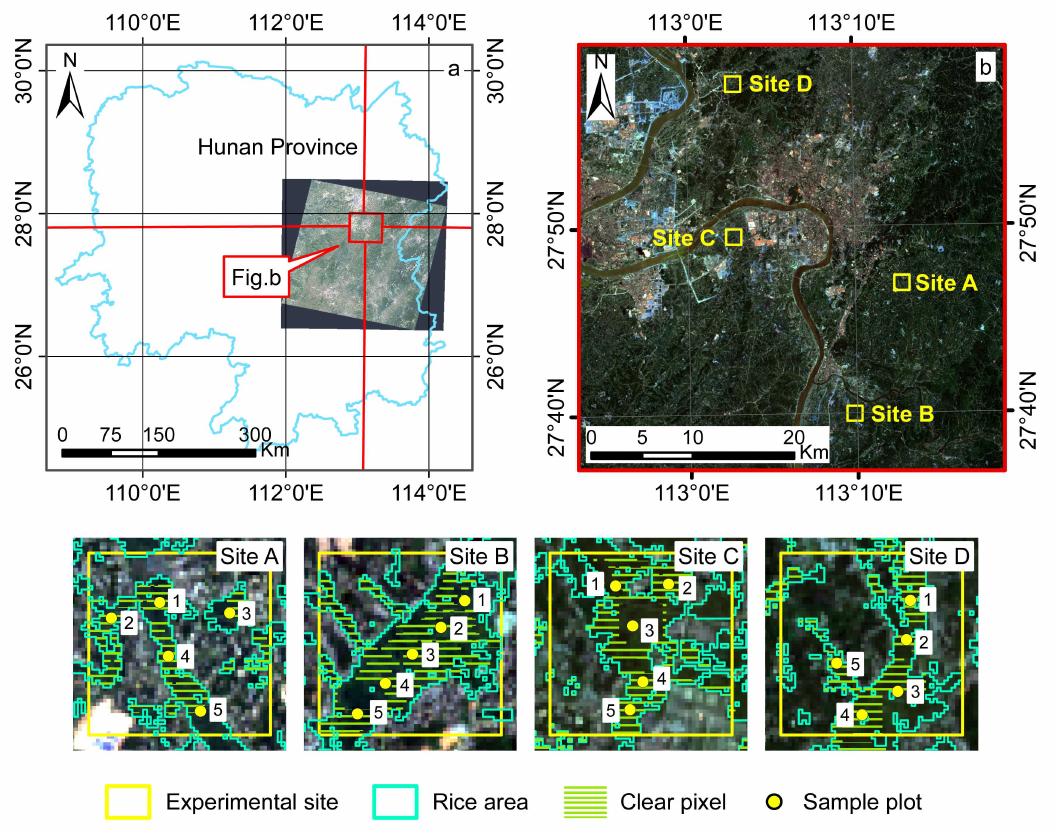
Figure 1. Location of the experimental sites in Zhuzhou, Hunan Province, China, and the spatial distribution of sample